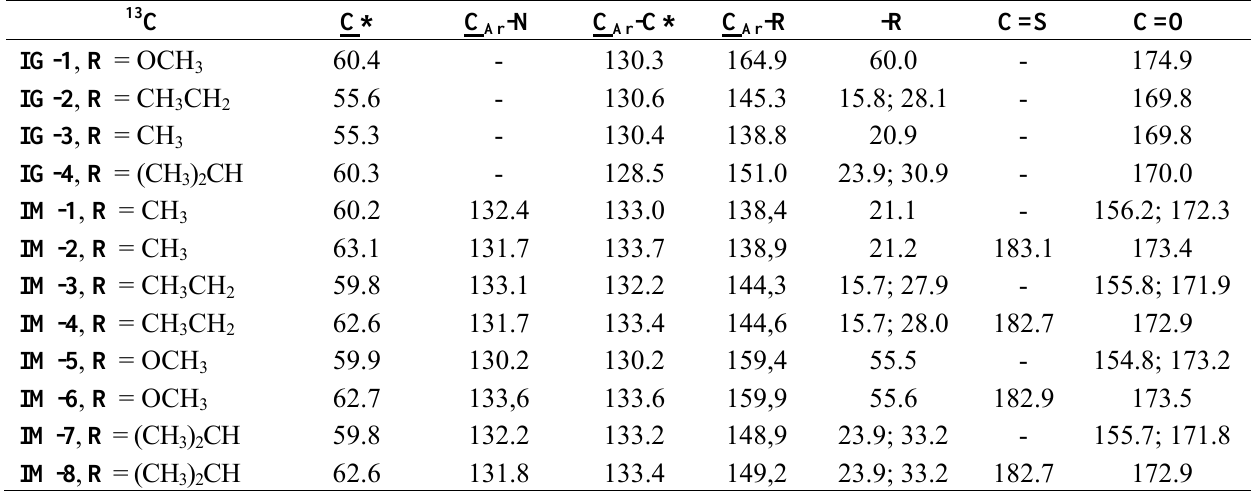
): Chemical shifts δ (ppm) from 6